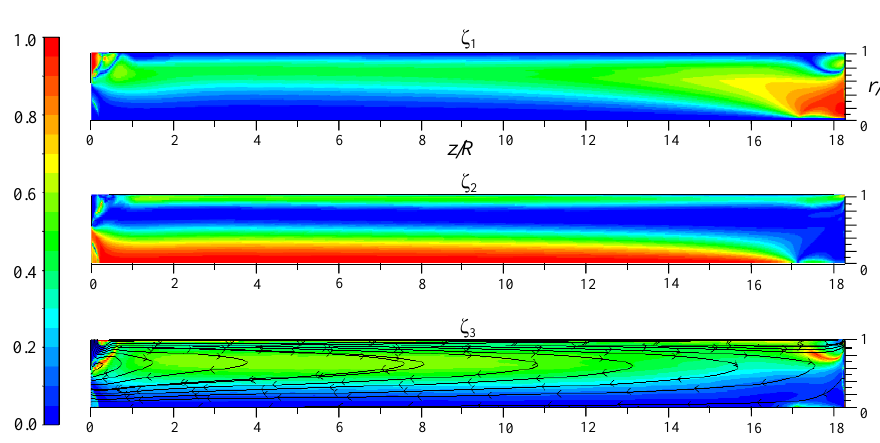
Figure 10. Figure 10.